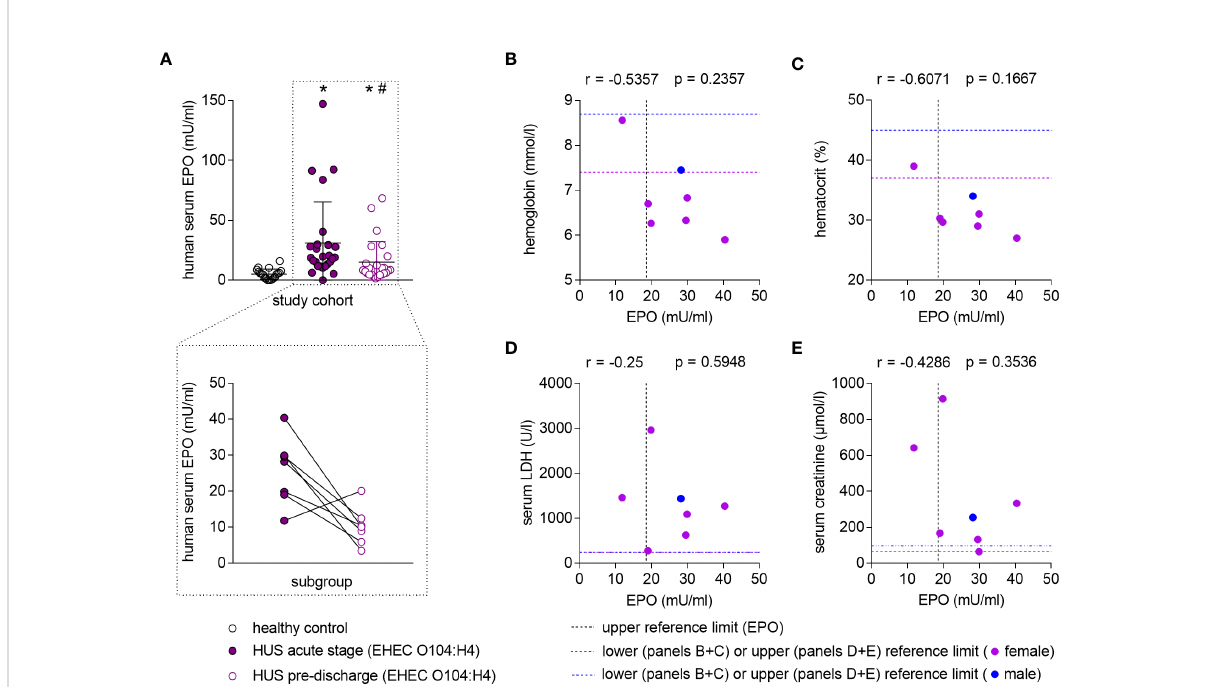
FIGURE 1 Endogenous EPO levels in patients with STEC-HUS and their correlation with anemia and kidney damage. (A) Upper panel: EPO serum levels in healthy controls (n = 20) and HUS patients (n = 26) within 10 d after admission to the hospital (HUS acute stage) and the last plasmapheresis (HUS pre-discharge) determined by ELISA. Data are expressed as scatter dot plot with mean ± SD. *P < 0.05 vs. healthy control (Mann-Whitney U-test), # P < 0.05 vs. HUS acute stage (Wilcoxon signed-rank test). Lower panel: Pairwise comparison of EPO serum levels of a subcohort of patients (n = 7) in which blood samples were available from day 1 to 3 after hospital admission and within 3 days before hospital discharge. Data are expressed as scatter dot plot with connecting line between respective measurements. (B-E) Correlation analysis implementing Spearman ’ s correlation coef fi cient (r) for correlations of endogenous EPO levels with (B) hemoglobin (n = 7), (C) hematocrit (n = 7), (D) lactate dehydrogenase (LDH, n = 7) and (E) creatinine (n = 7) in the subcohort. The upper reference limit for EPO in health are indicated by dashed vertical lines. Gender-speci fi c lower or upper reference limits for the respective parameters of anemia and kidney damage are indicated by dashed horizontal lines.